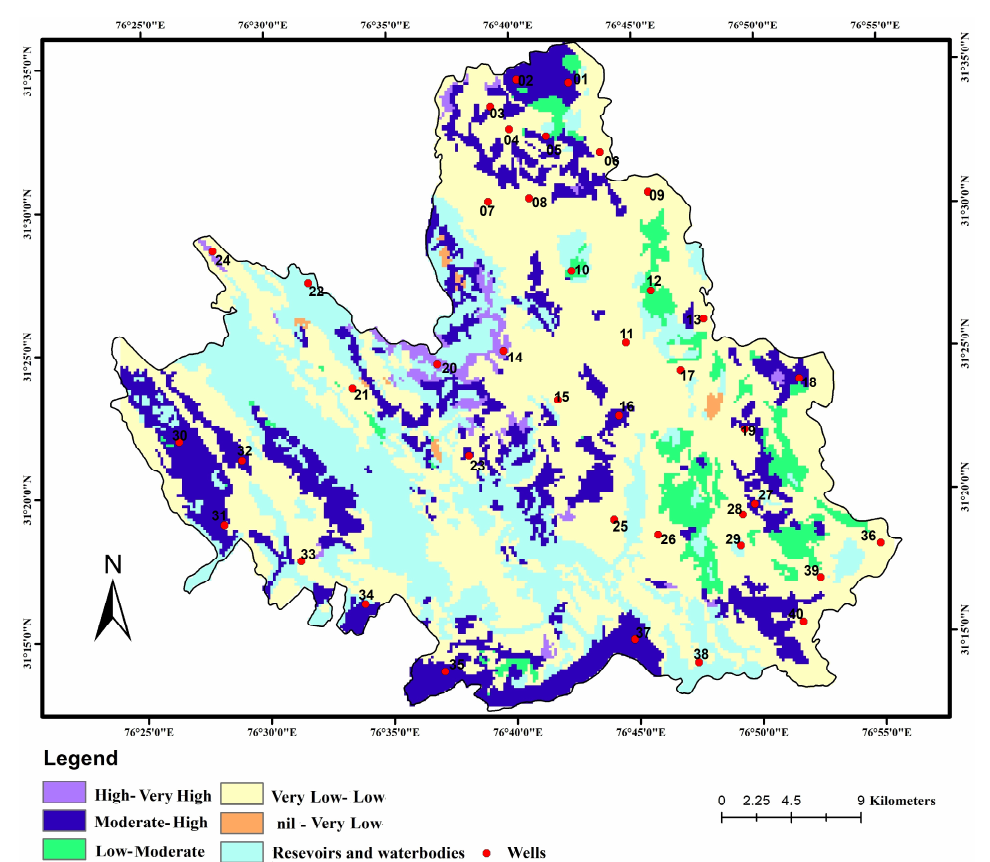
Figure 15. Groundwater potential zone map of study area, Bilaspur overlaid by the well location data.